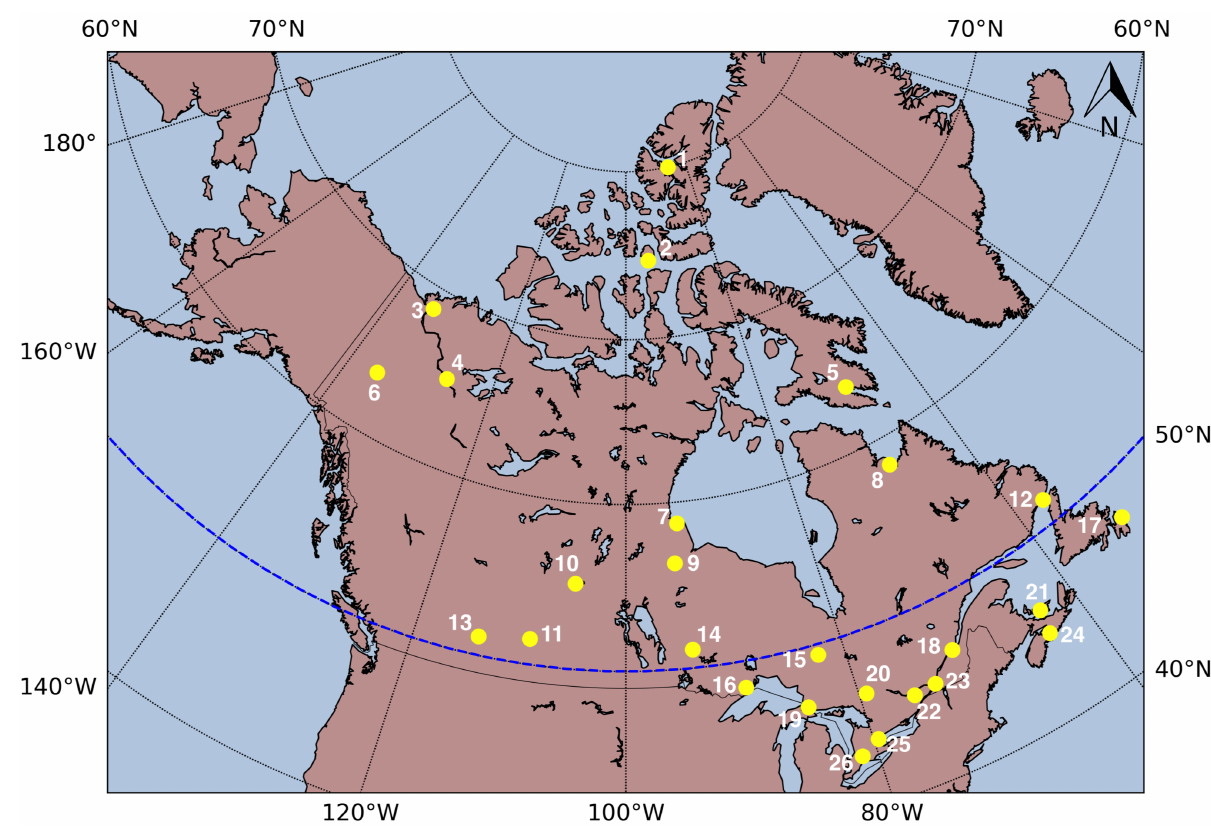
Figure 1. Distribution of ECCC weather stations used in this study as listed in Table 3. The dotted blue line shows the 50 ◦ N parallel, which separates northern from southern stations in the pan-Canada